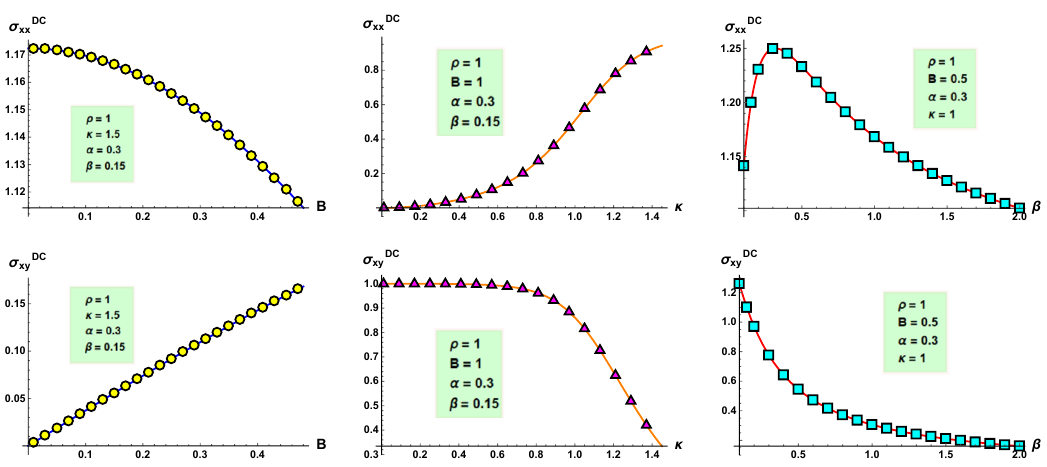
Figure 16 . Comparison between the numerical conductivities at ! = 0 (markers) and the DC formulas in equations (6.3) (lines). For simplicity we (cid:12)xed u h = 1. The agreement is